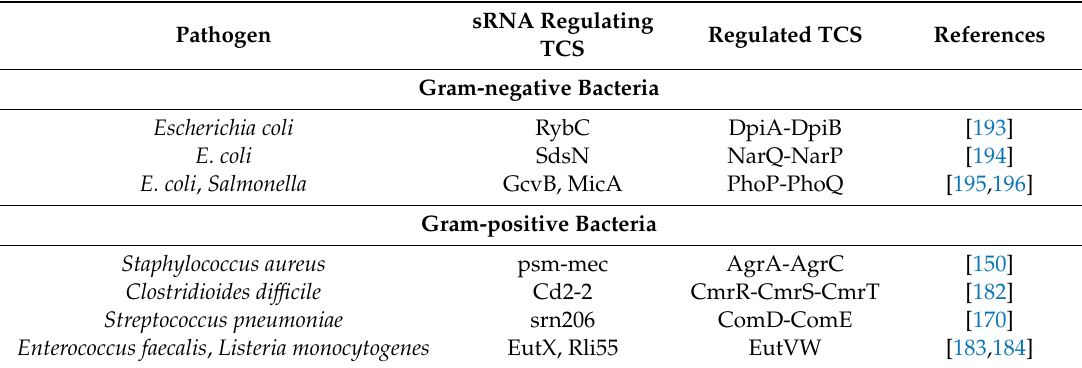
Table 2. Examples of sRNAs regulating